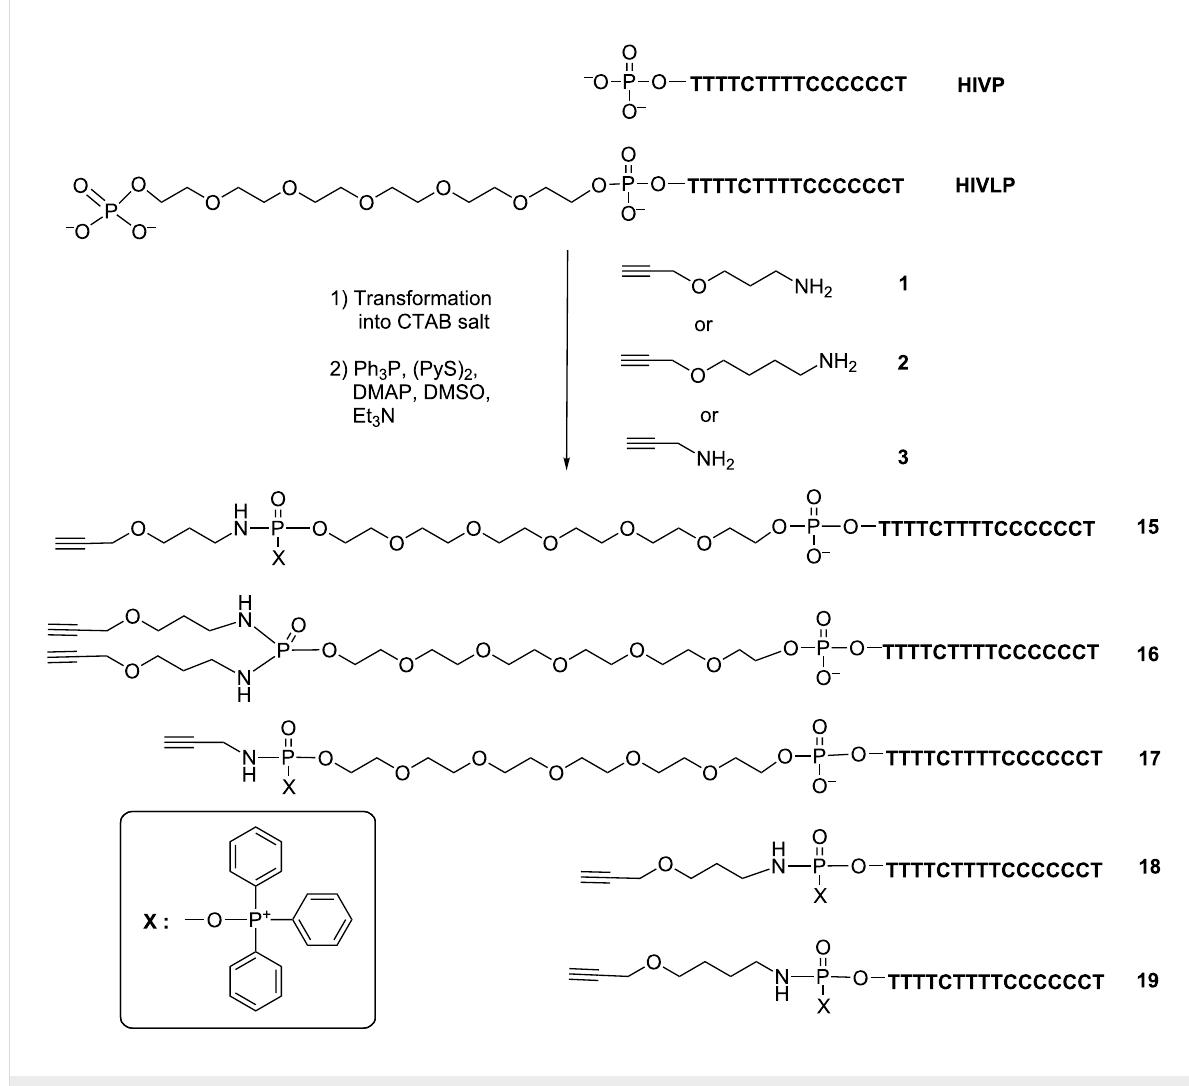
Figure 9: Synthesis of modified oligonucleotides containing an alkyne group.